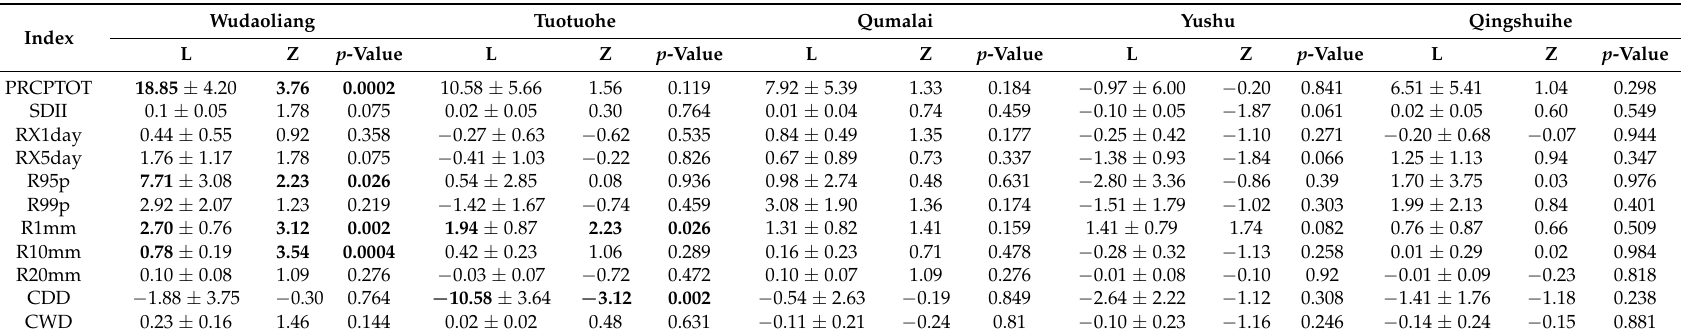
Table 4. Linear trends and results of the Mann–Kendall (MK) test for extreme precipitation indices for each station in the SRYR during